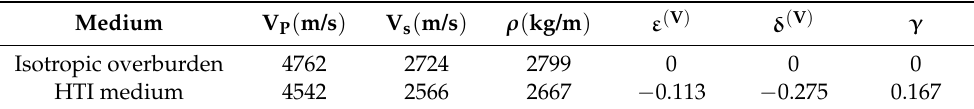
Table 1. model parameters. Table 1. Model parameters.